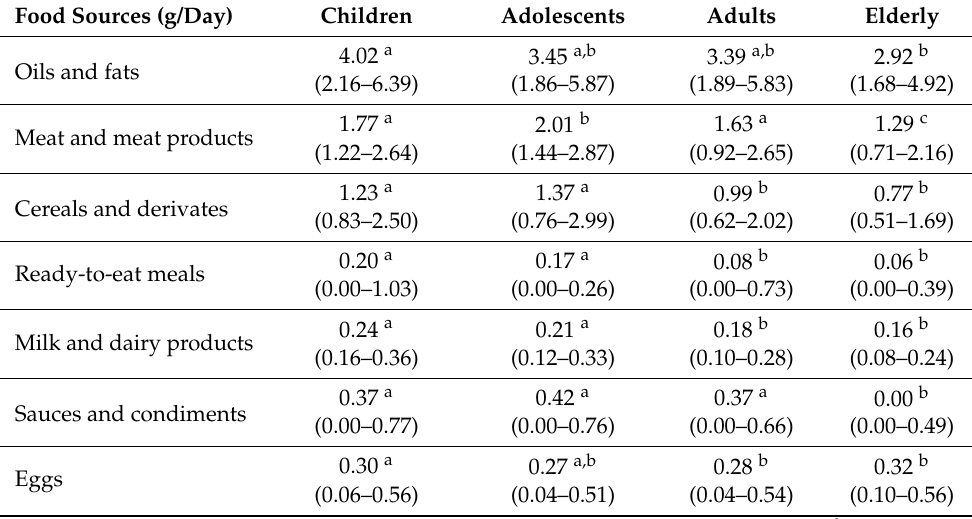
Table 18. Contribution of dietary food sources to total omega-6 intakes per age group among the ANIBES Study